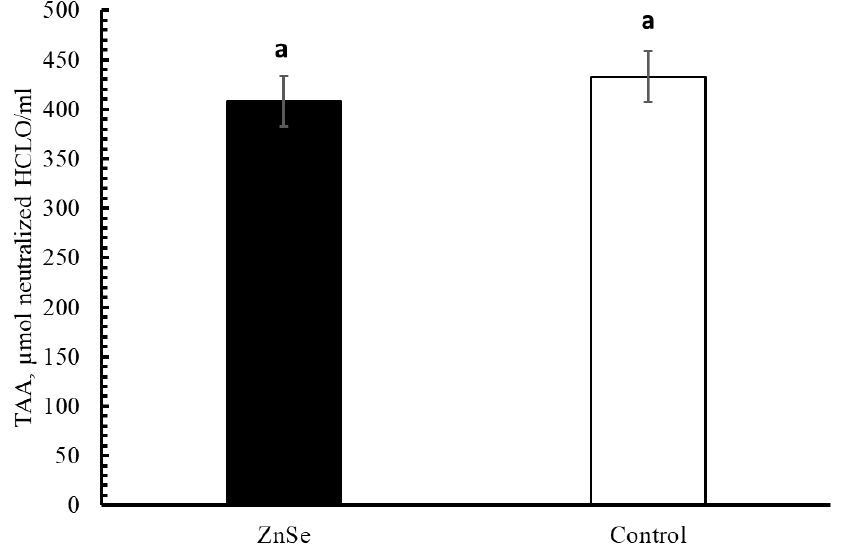
Figure 4. Lsmeans ( ± SE) of total antioxidant activity (TAA) of milk in the experimental groups. a Same letters indicate no significant differences